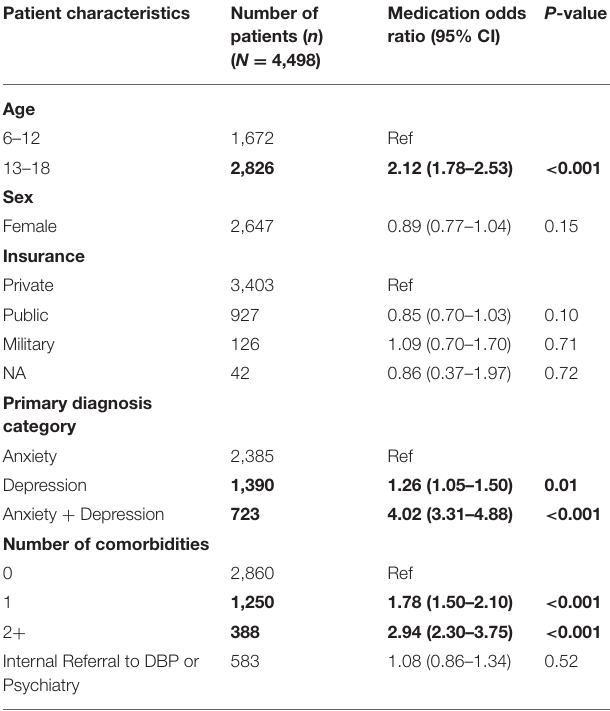
TABLE 3 | Patient characteristics associated with medication prescription for patients with anxiety only, depression only, and both